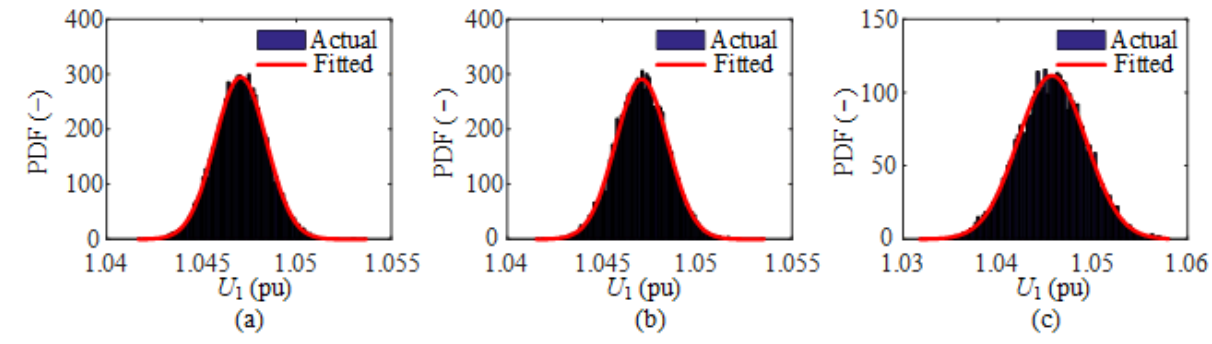
Figure 5. PDF of estimated voltage U 1 with different methods. ( a ) ITS-ETC-SE approach, ( b ) AJ-ETC-SE approach, ( c ) WLS-SE method.